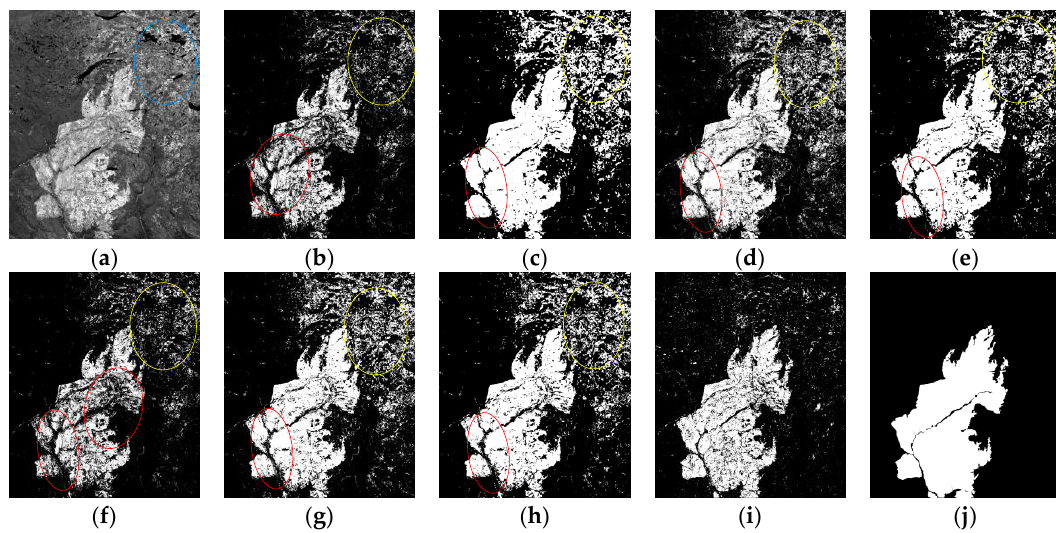
Figure 11. Results of the Canada dataset. ( a ) Difference image, the blue ovals refer to the local brightness deformation region. ( b ) KI. ( c ) MRF+EM. ( d ) FCM. ( e ) FLICM. ( f ) GA-mask. ( g ) GA-FCM. ( h ) MOEA/D. ( i ) Proposed M-DECD. ( j ) Reference map.